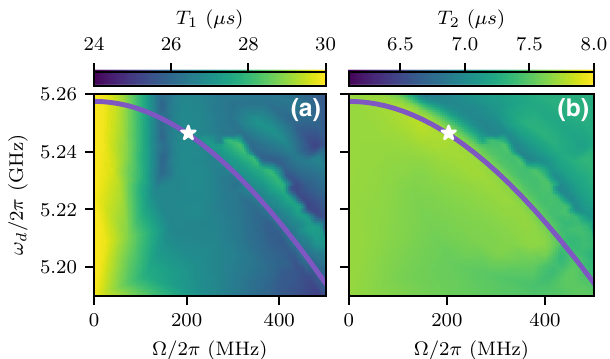
FIG. 6. Effective T 1 (a) and T 2 (b) that account for the extra decoherence caused by the drive during the time slot T slot = 440 ns. We can see that the variation is small as a function of the drive amplitude compared to the values at (cid:6) = 0. The white star indicates the chosen operating point ( (cid:6)/ 2 π ≈ 204 MHz, / 2 π ≈ 5.2464 GHz, t = 178.6 ns; see Sec. I B). The purple ω d p line corresponds to the higher-order estimate of the optimal drive as a function of (cid:6) [see Fig. 1(c)]. The heatmaps are frequency ω ∗ d sampled using the ADAPTIVE package [66].